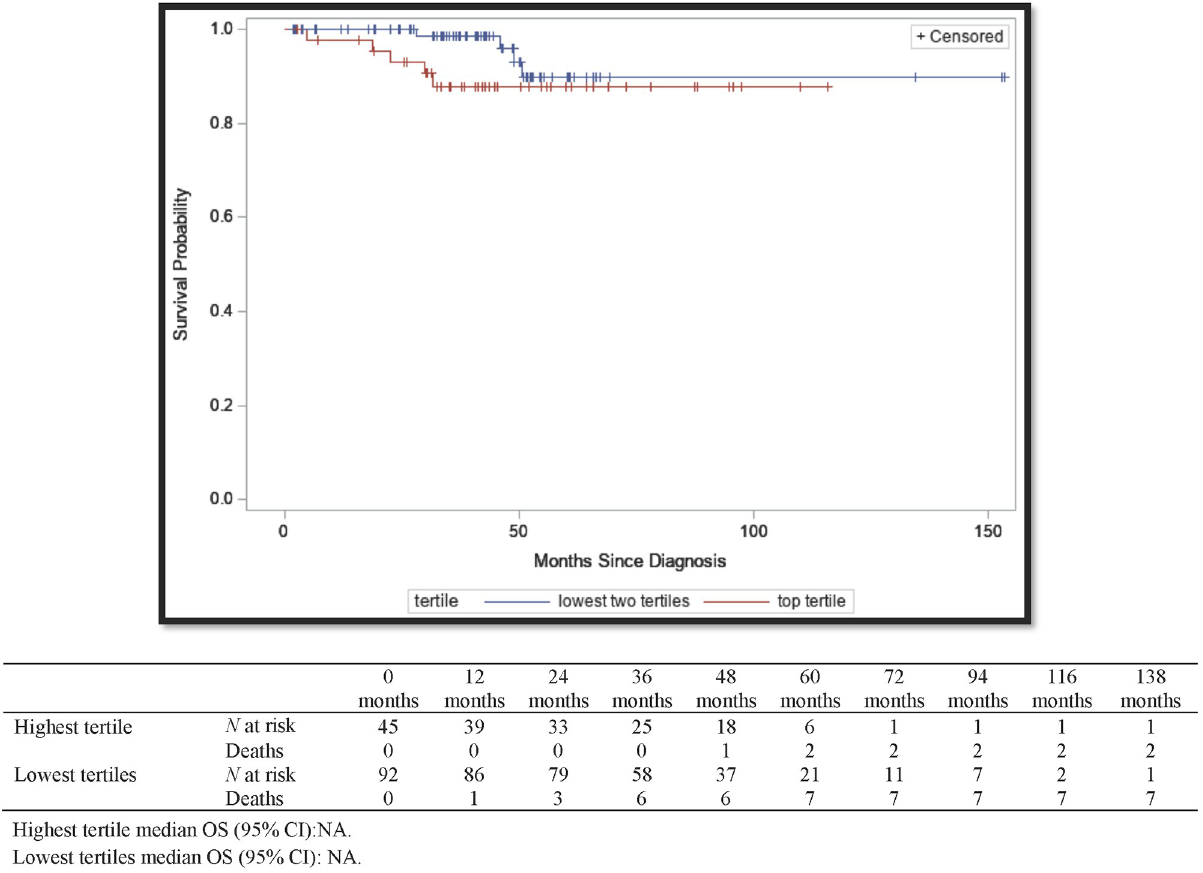
Fig 3. Kaplan–Meier survival curves for overall survival of NMIBC by highest tertile of IFN- γ signature vs the lowest two tertiles. Mt Sinai hospital system and North Shore Long Island Jewish health system, New York, New York. 2004–2017. Highest tertile median OS (95% CI):NA. Lowest tertiles median OS (95% CI):